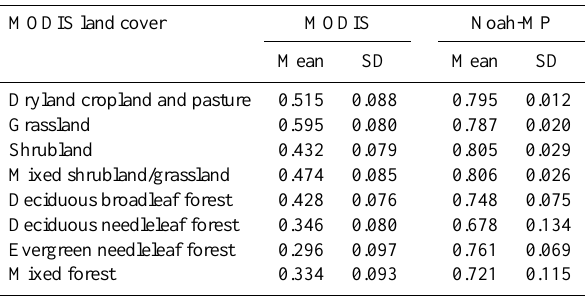
Table 4. The values of mean and standard deviation (SD) of snow albedo from the MODIS observation and the Noah-MP results for the shortwave broadband for different categories of the MODIS land cover. The data are averaged for winter time in 2001–2010 over each vegetation type within 40–60 ◦ N and 105–145 ◦ E with correspond- ing SD when SCF equals 100% and other snow conditions are the